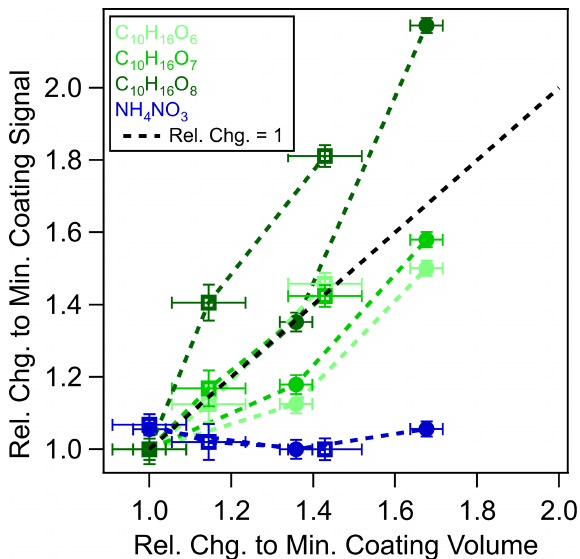
Figure 4. Relative changes of α -pinene ozonolysis products coated on NH 4 NO 3 particles at 156 ( ) and 226nm ( (cid:3) ) core sizes. The coating volume ( x axis) measured by an SMPS is normalized by the smallest coating volume, and the coating signals ( y axis) of C 10 H 16 O 6–8 molecules as measured by the EESI-TOF are normal- ized by the signals observed at the smallest coating volume. The largest coating thicknesses are 19.8 and 26.8nm for 156 and 226nm core sizes of the NH 4 NO 3 particles, respectively. The black line de- notes a relative change of the coating signal and volume equal to